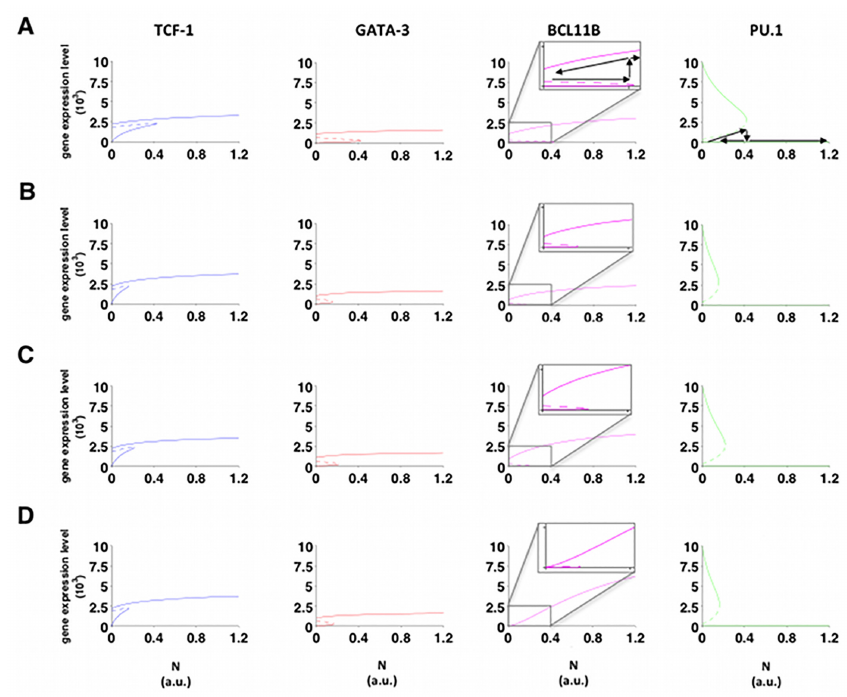
Fig 4. Bifurcation analysis. Bifurcation analysis with respect to the maximum value for the Notch signalling for the winning combinatorial configurations: (A) dimer TCF-1 AND (Notch OR dimer GATA-3) ; (B) dimer GATA-3 AND (Notch OR TCF-1) ; (C) dimer GATA-3 AND (Notch OR dimer TCF-1) ; (D) Notch AND TCF-1 AND dimer GATA-3 . Blue lines: TCF-1; red lines: GATA-3; magenta lines: BCL11B; green lines: PU.1. Continuous lines: stable states; dashed lines: unstable states. For BCL11B the bifurcation region is enlarged for the bistability regions in the different solutions. For both BCL11B and PU.1 arrows are drawn along the paths when increasing or decreasing the maximum Notch value.